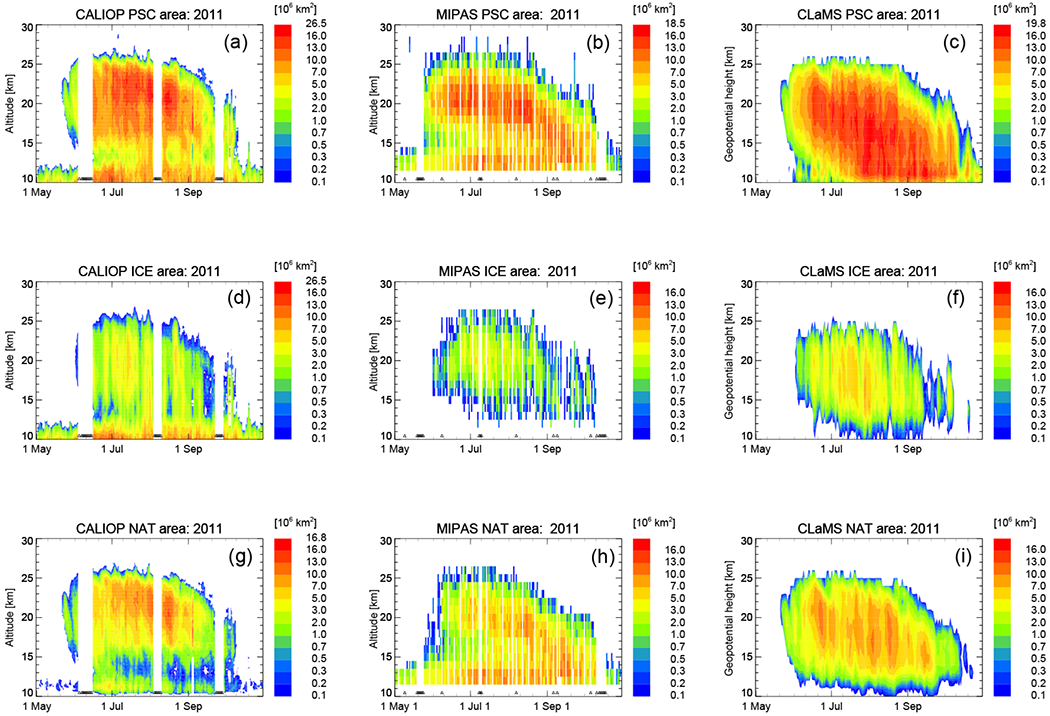
Same as Fig. 2 but for the 2011 SH winter from 1 May 2011 until 31 October 2011. Here, MIPAS observations and CLaMS simulations are restricted to latitudes < 82° S. Please note that the color code is always identical except for the maximum value of the top color bin.